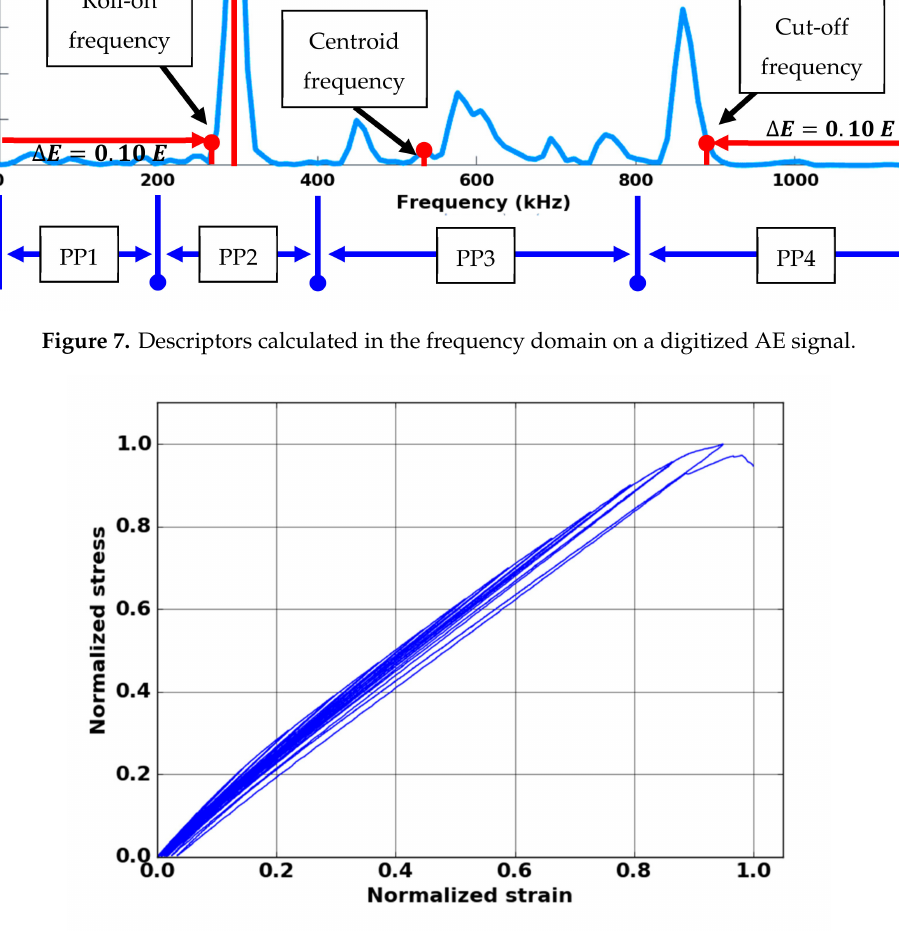
Figure 8. Stress versus strain normalized curve obtained from cycled tensile test in fiber orientation of oxide–oxide